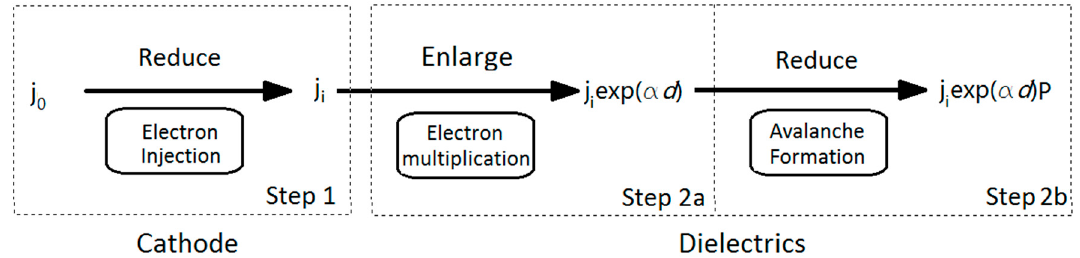
Figure 9. Schematics of the breakdown model by F. Forlani.